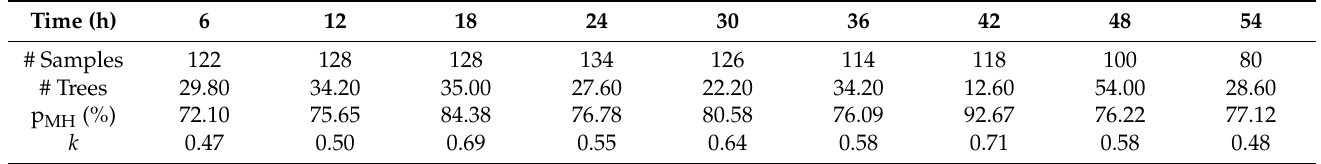
Table 1. Performance metrics of our classification model for each lead-time (in hours, h) in the Atlantic Ocean. The positive and negative predictive power of the model for both classes (TSs and MHs) has been assessed using Cohen’s kappa statistic (k). The model precision (p MH ) reflects the accuracy for predicting the MH class. The values for each metric report the mean result across all folds from all runs. The number of trees (# Trees) corresponds to the number of trees when the “performance saturation” condition is met. The number of samples (# Samples) is the total number of events (50% were TSs and 50% MHs).